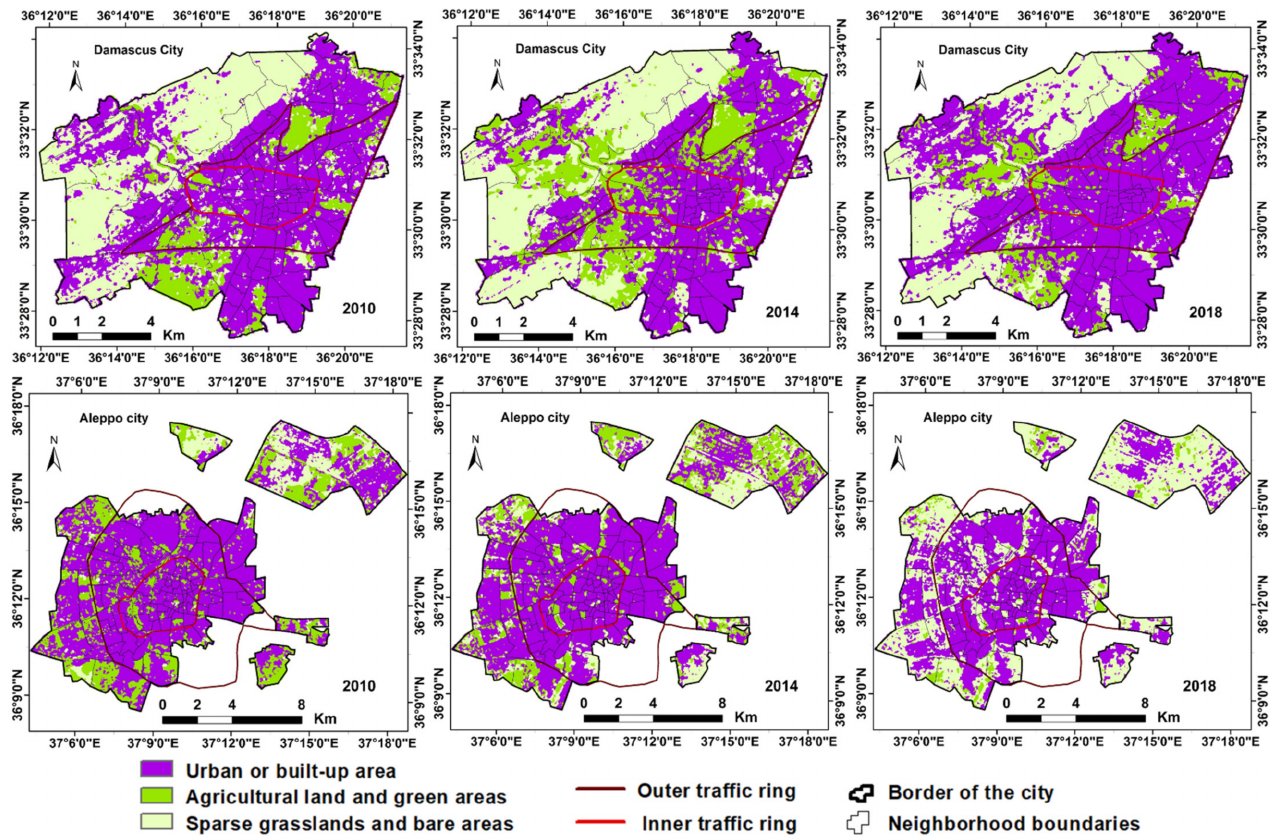
Figure 3. Time series of LULC maps of the study area between 2010 and 2018. The area (in %) of LULC categories after calculating adjusted area